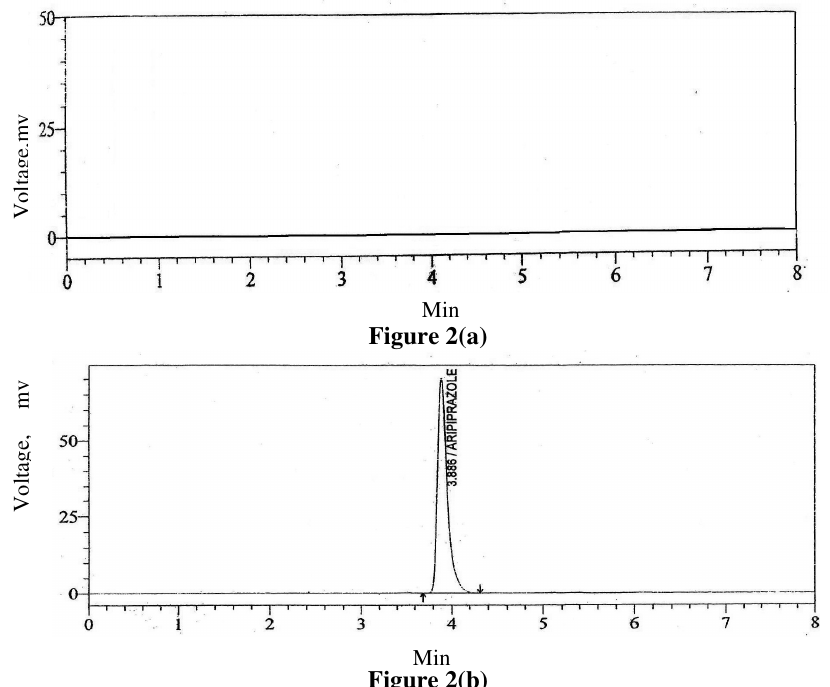
Figure 2. (a) Typical chromatograms obtained from blank and (b) aripiprazole